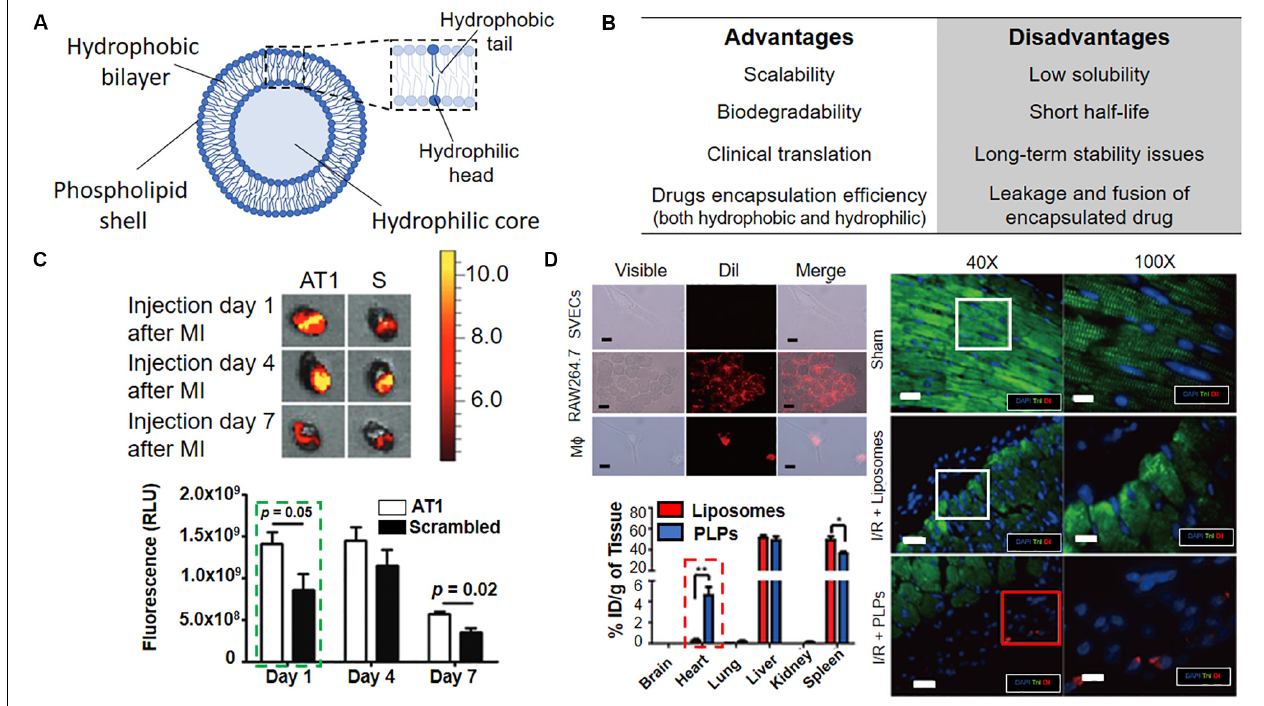
FIGURE 6 | Liposomes for active targeting of infarcted heart. (A) Schematic representation of liposomes with overall composition and structure. (B) Advantages and disadvantages associated with the use of liposomes. (C) Top. In vivo bioluminescence images of infarcted mouse hearts injected either with AT1 or scrambled (S) liposomes and analyzed at the indicated timepoints indicate AT1-liposomes preferential accumulation in the tissue (orange/red signal). The graph shows the quantification of the fluorescence due to AT1- and scramble-liposomes accumulation at the given timepoints. (D) Top left. Dil-labeled-Platelet-like proteoliposomes (PLPs) selectively interact with RAW264.7 monocytic cell line and macrophages (M φ ) but not with SVECs endothelial cells, as indicated by the red signal. Scale bar 10 µ m. Dil = 1,1 (cid:48) -Dioctadecyl-3,3,3 (cid:48) ,3 (cid:48) -Tetramethylindocarbocyanine Perchlorate. Bottom left. Intravenously injected PLPs accumulate in the heart more efficiently than liposomes 72 h post-infarction * p < 0.05, ** p < 0.01. Right. The persistence of Dil-labeled PLPs in the infarction area in a mouse model of ischemia/reperfusion (I/R + PLPs, red square) as compared to Dil-labeled liposomes (I/R + Liposomes, white square) and sham control. Troponin I (TnI, green), stains the heart muscle, Dil (red) injected liposomes, cell nuclei are counterstained with DAPI (blue), Scale bar were not reported in the original article. Reprinted and adapted from: (C) (Dvir et al., 2011) with permission from American Chemical Society; (D) (Cheng et al., 2016) with permission from